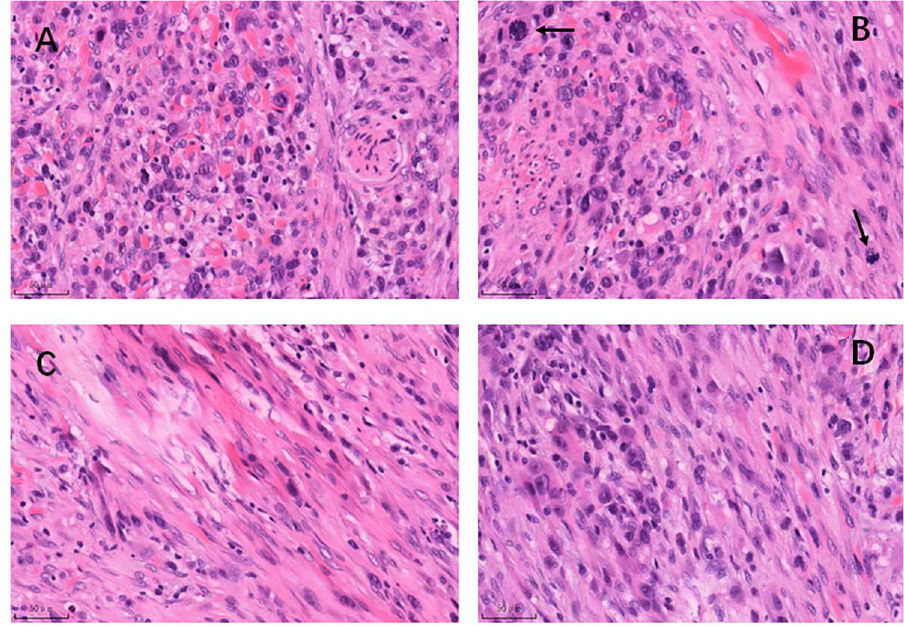
Fig. 1 Microscopic findings of epithelioid and spindle cells rhabdomyosarcoma: Hematoxylin-eosin staining shows tumor is primarily composed of epithelioid cells and spindle cells, epithelioid cells show prominent cellular pleomorphism with obvious nucleoli, abundant and brilliant eosinophilic cytoplasm (Fig. 1A), and visible mitotic figures (Fig. 1B), spindle cells show hyperchromatic nucleus with prominent nucleoli and brilliant eosinophilic cytoplasm (Fig. 1C), two components can intertwine with each other in some regions (Fig. 1D). Bar: 50 μm,